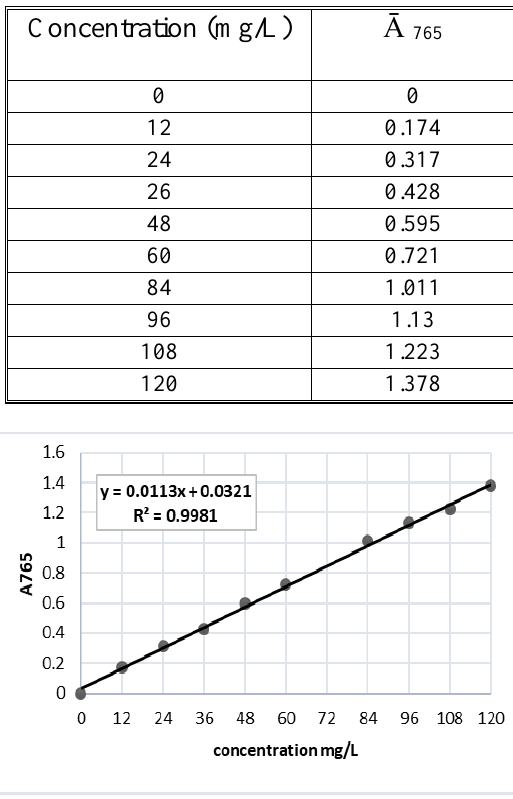
Figure 1. Gallic acid calibration curve TPC of the